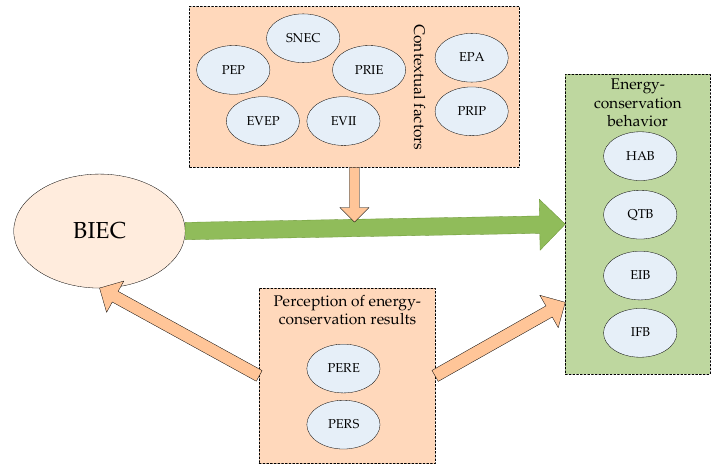
Figure 1. Conceptual framework of energy conservation behavior (ECB).